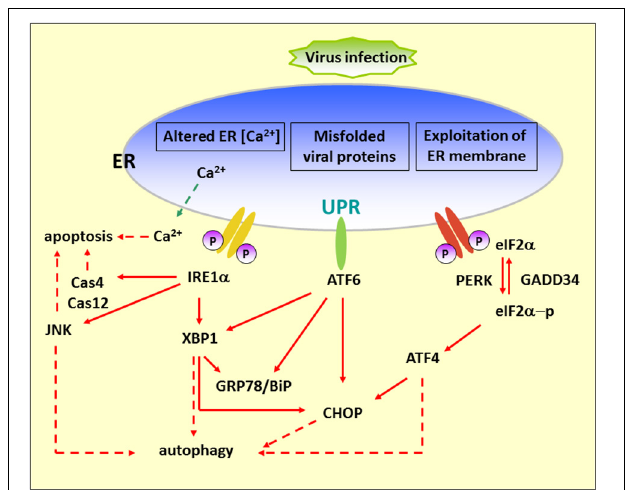
FIGURE 1 | Diagram of the UPR arms and their connection to autophagy. Alteration of ER functions results from stress signals by RNA virus infection, by the exploitation of ER membrane for viral replication, rapid accumulation of viral proteins, imbalance of calcium concentration by viroporin, and the sabotage or depletion of ER membrane for viral release. This leads to the accumulation of misfolded and unfolded proteins, which triggers ER stress. To alleviate this adverse effect, the cells operate an adaptive UPR to reduce the load of the newly synthesized proteins in the ER by activating the PERK–eIF2 α branch and eliminating inappropriate protein accumulation by upregulating ER chaperone proteins through IRE1 and ATF6 branches. In addition, the incurable misfolded proteins undergo retrotranslocation from the ER into cytosol for degradation by an ERAD mechanism. ER stress can contribute to autophagy via activation of JNK, XBP1, CHOP, and ATF4. Red dash arrows indicate the final outcome of the activated pathways, such as apoptosis and autophagy, caused by viral infection. Red solid arrows indicate the UPR